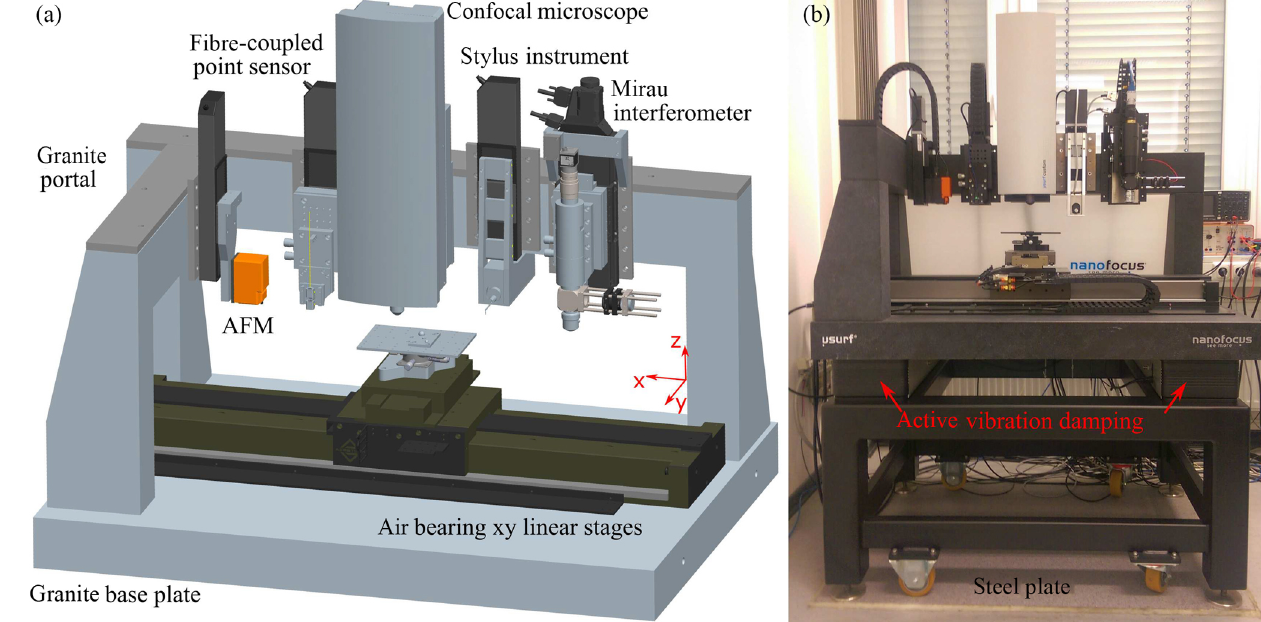
Figure 1. Schematic representation of the multi-sensor measuring system with five different topography sensors (a) and a photograph of the measuring system with active vibration damping on a steel plate reducing mechanical environmental vibrations (b)